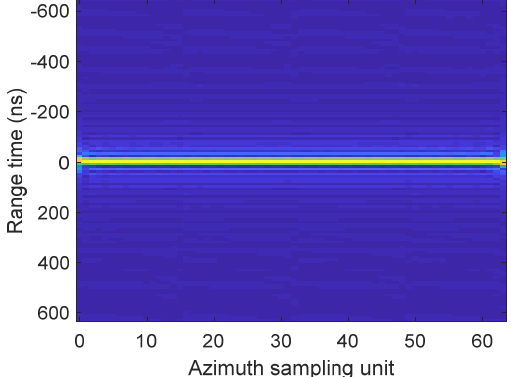
Figure 7. The result after the modified Keystone transformation. Figure 8 is the result after the azimuth compression. The red box indicates that the compressed data only occupies a small part of the range-Doppler plane. The data transmis- sion is carried on after the azimuth compression. The data volume in the transmission is related to the width of the two first lobes of the compressed data, and the width is inversely proportional to the signal bandwidth in the range domain. Thus, the amount of data to be transmitted is significantly reduced for a wideband signal.